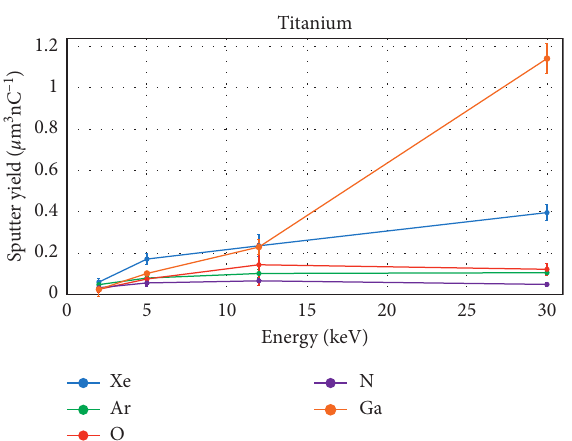
Figure 7: Sputter yield of titanium milled with different ion species at varying